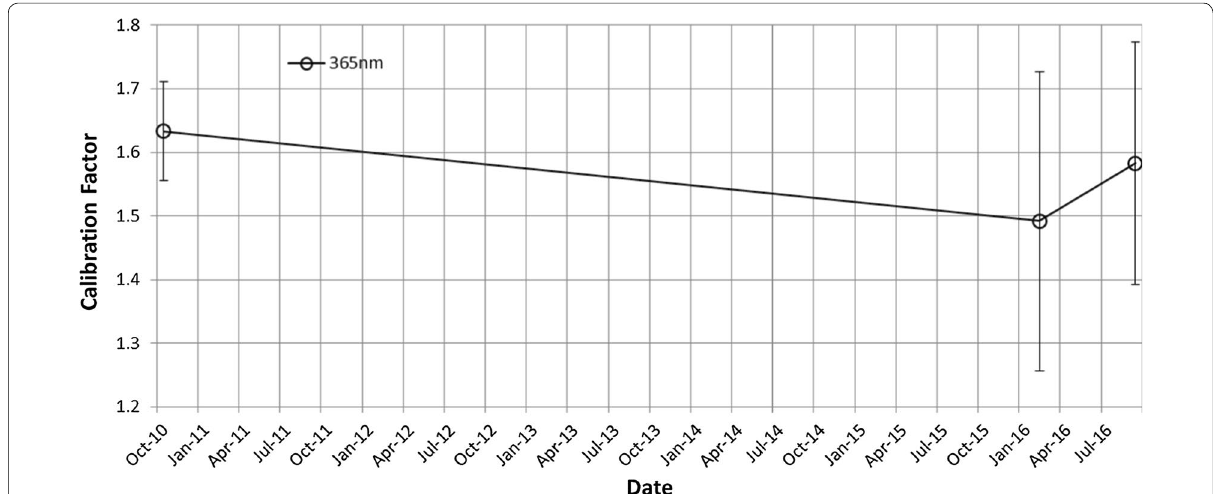
Fig. 8 Time variation of calibration factor for the 365‑nm channel